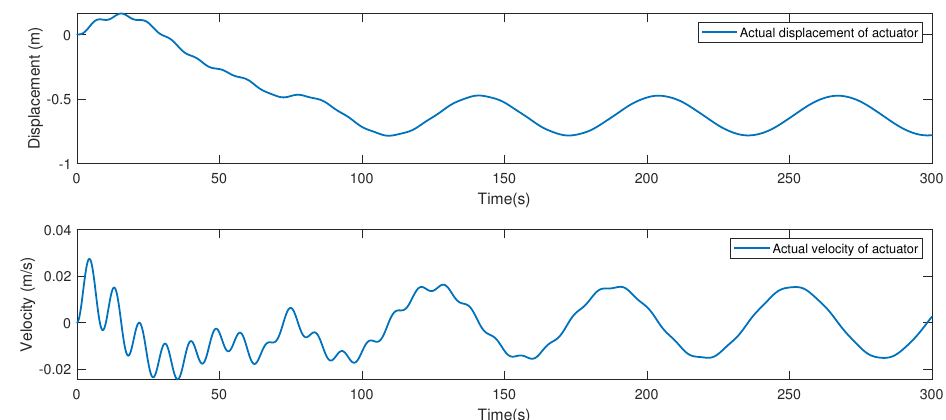
Figure 11. The position and velocity trajectory of the SEA actuator.